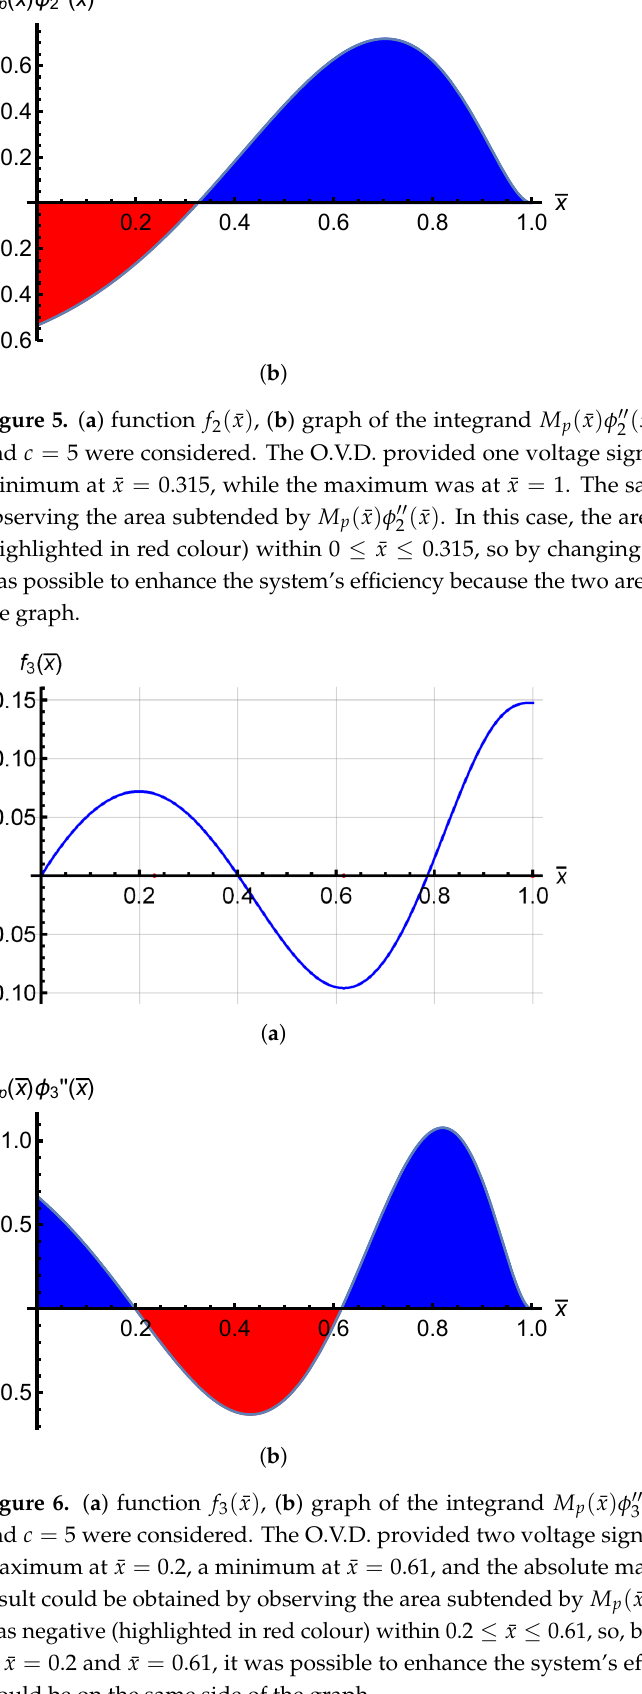
Figure 6. ( a ) function f 3 ( ¯ x ) , ( b ) graph of the integrand M p ( ¯ x ) φ (cid:48)(cid:48) and c = 5 were considered. The O.V.D. provided two voltage sign changes: f 3 ( ¯ x ) included a local maximum at ¯ x = 0.2, a minimum at ¯ x = 0.61, and the absolute maximum was in ¯ x = 1. The same result could be obtained by observing the area subtended by M p ( ¯ x ) φ (cid:48)(cid:48) was negative (highlighted in red colour) within 0.2 ≤ ¯ x ≤ 0.61, so, by changing the voltage sign both at ¯ x = 0.2 and ¯ x = 0.61, it was possible to enhance the system’s efficiency, because the three areas would be on the same side of the